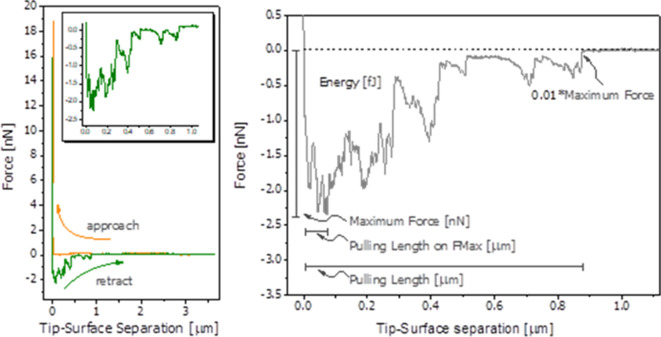
Representative force spectroscopy curve of hydrated OPN.